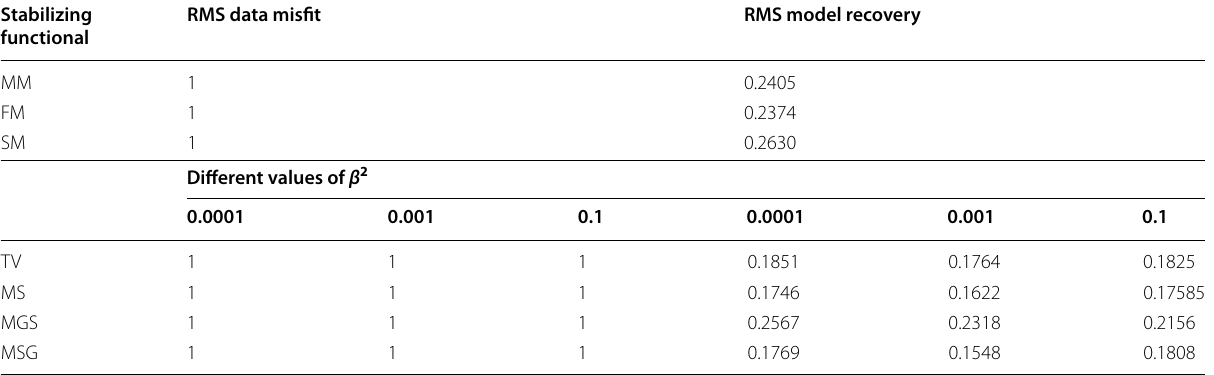
Table 1 RMS data misfit and RMS model recovery of different stabilizing functionals for the 1D-layered model A (Fig. 2a) Stabilizing functional